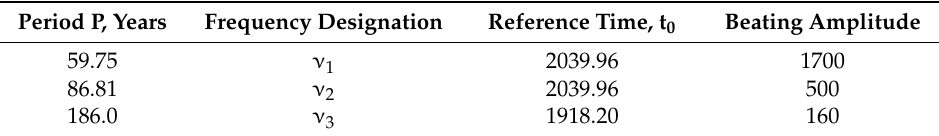
Table 1. The nature of multidecadal tidal components in this parameterization. Beating amplitudes for the multidecadal cycles are the respective heights of the envelopes shown in the Appendix